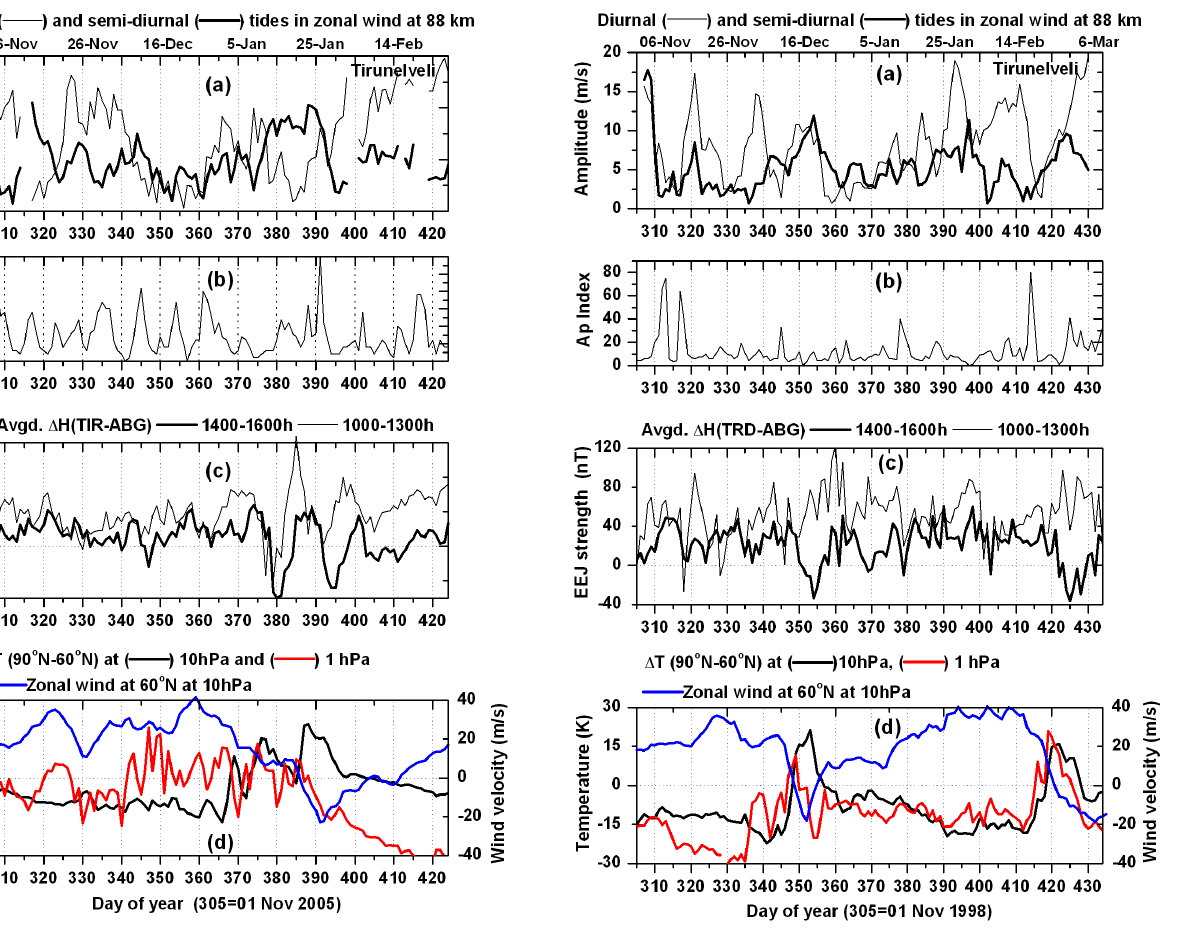
Fig. 2. Same as Fig. 1, but for a time interval 1–130 days starting from 1 November